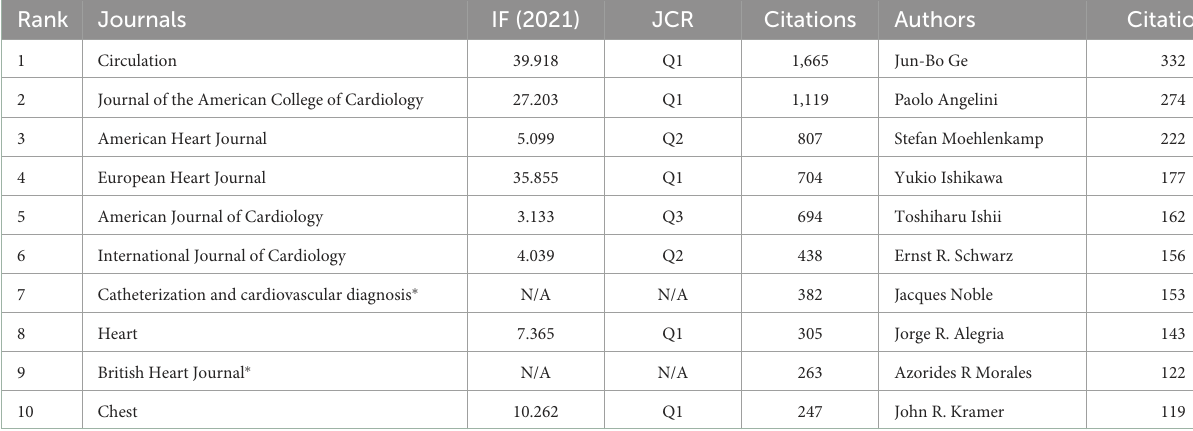
TABLE 4 Top 10 journals and authors with the highest